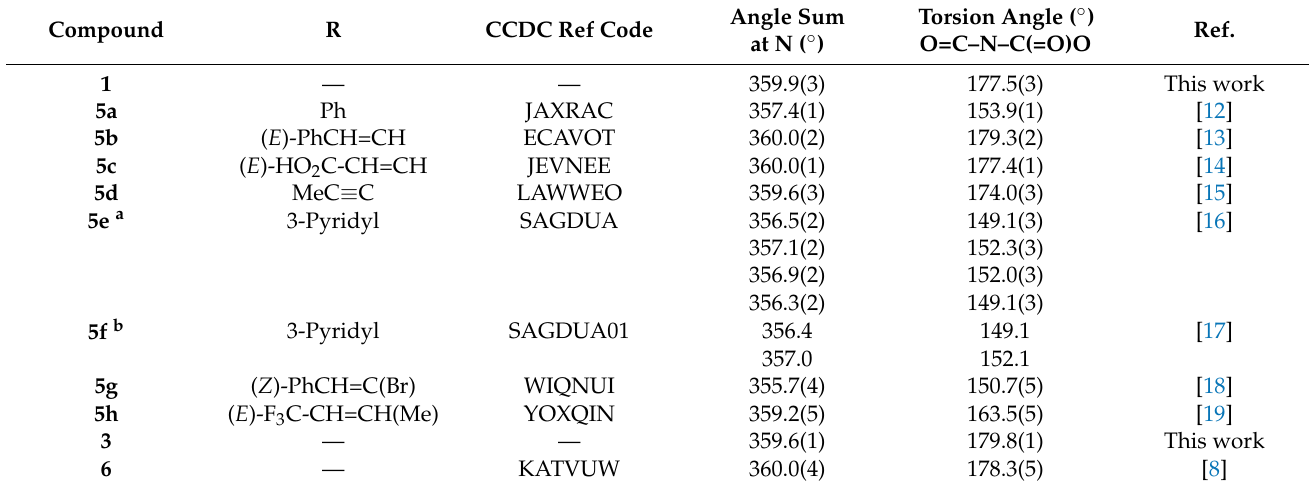
a 4 independent molecules b 2 independent molecules.